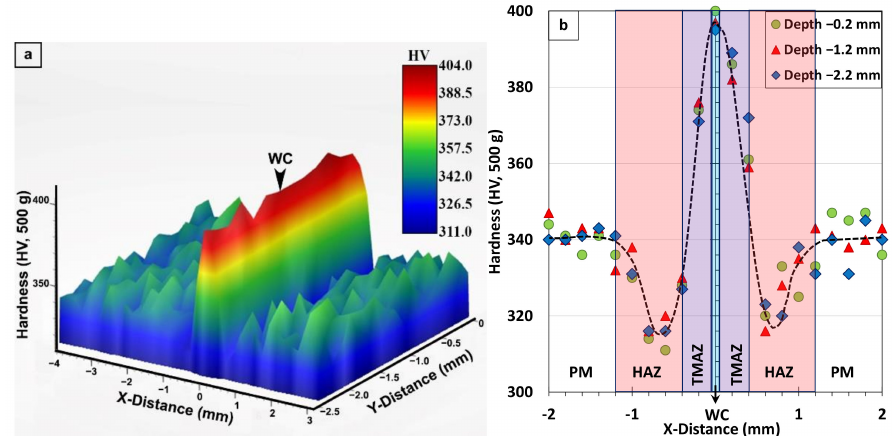
Figure 8. Hardness of the Ti-6242 weld in AWed condition: ( a ) 3D map and ( b ) profiles showing the different regions, where x-distance and y-distance are along the joint length and depth, respectively.